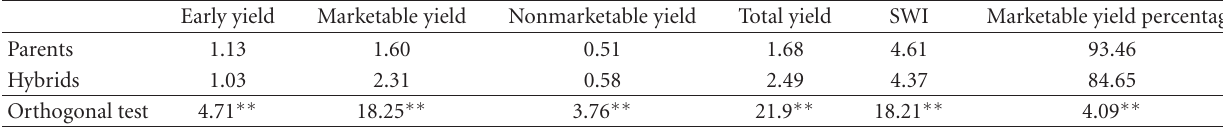
Table 2: Parent versus hybrids orthogonal comparisons.